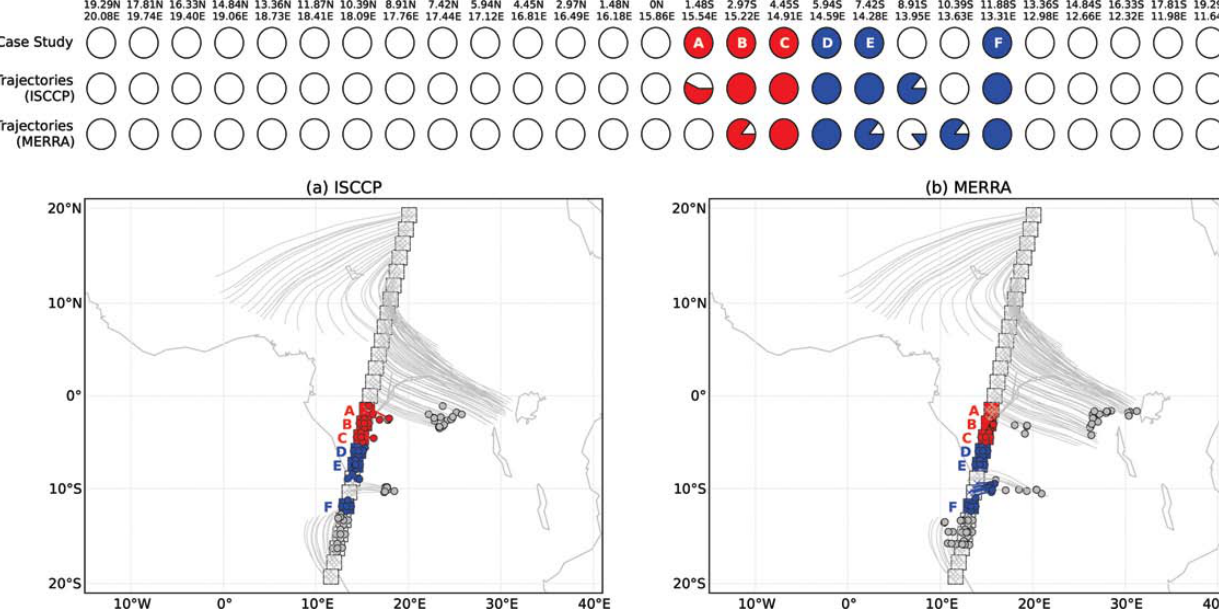
of the trajectory starting points. The automated method